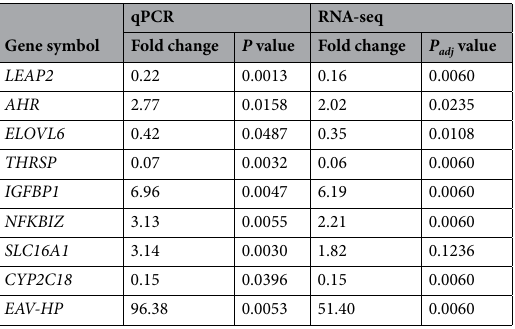
Table 2. Expression patterns of the 11 mRNAs selected for qPCR validation.